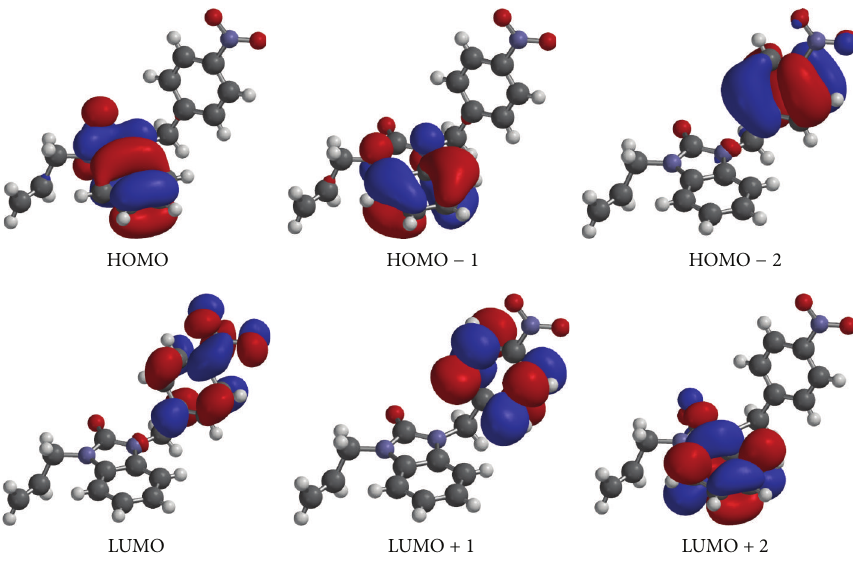
Figure 11: Frontier orbitals. HF/3-21G ∗ from X-ray